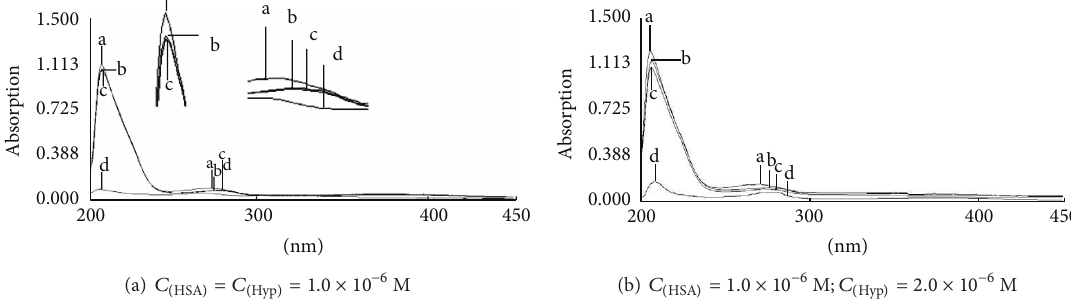
Figure 5: The absorption spectra of HSA, Hyp, and Hyp-HSA system. a: [Hyp-HSA], b: [HSA], and c: [Hyp-HSA]—[Hyp], d: [Hyp].